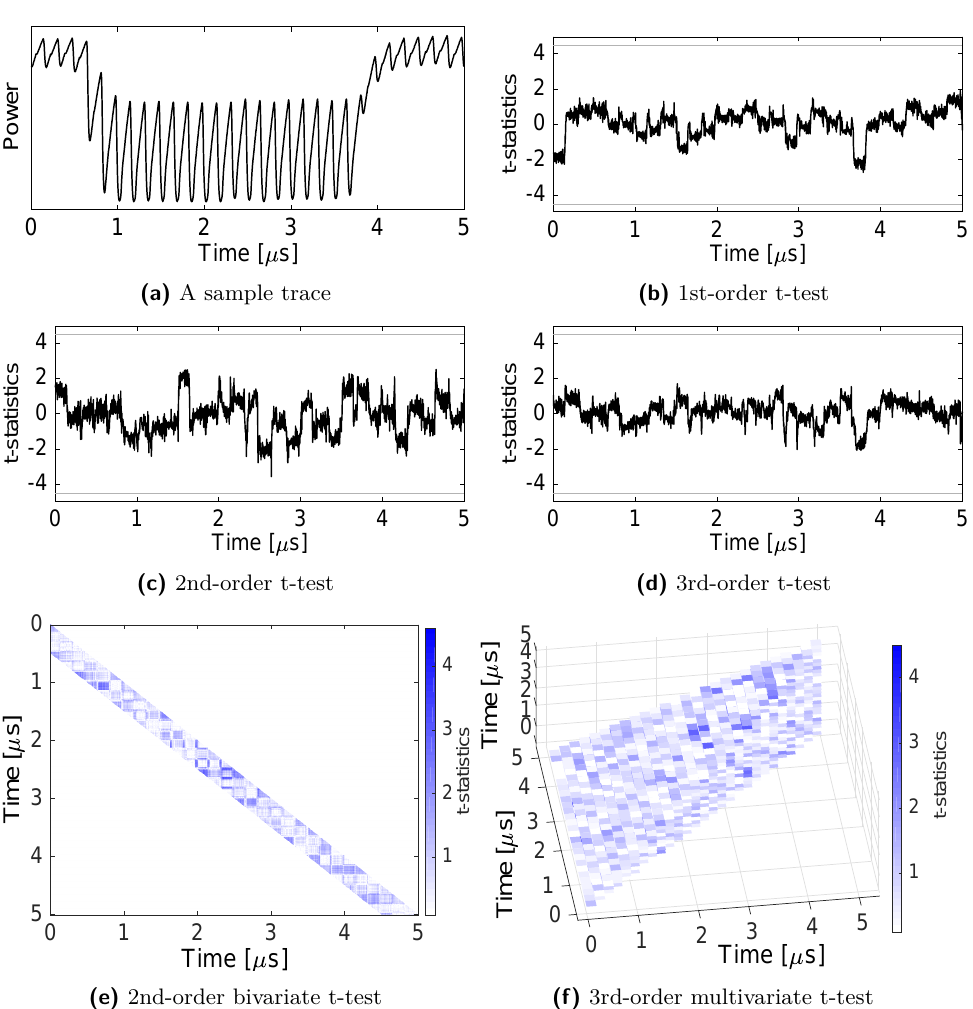
Figure 7: Experimental analysis of our four-share Keccak - f [200] design using 100 million